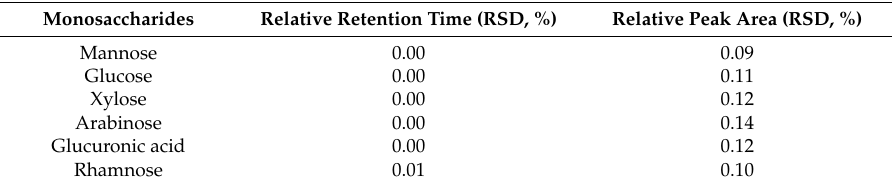
Table 1. The statistical results of the intra-day precision of the monosaccharides ( n = 6).